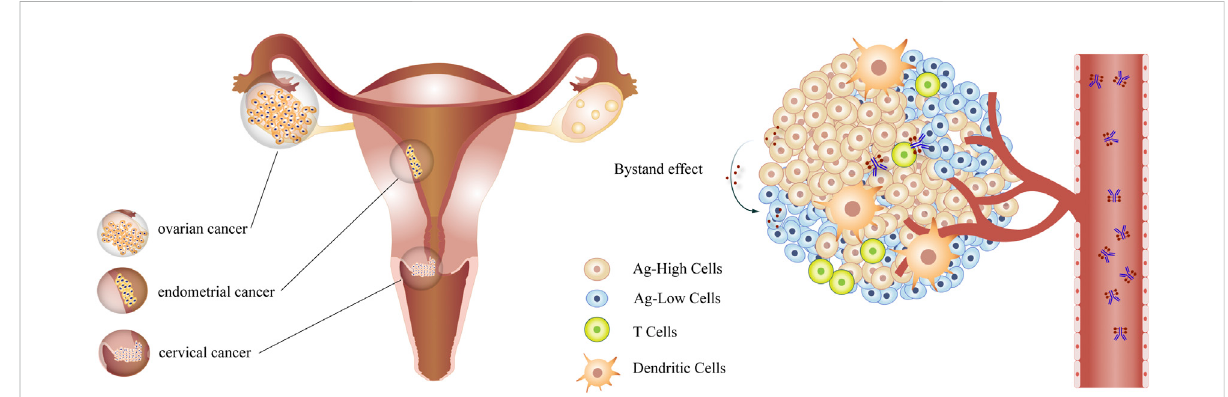
FIGURE 1 The ADCs in gynecologic cancer ADCs target antigen-high cells in gynecological tumors through the circulation and kill antigen-low cells by bystander